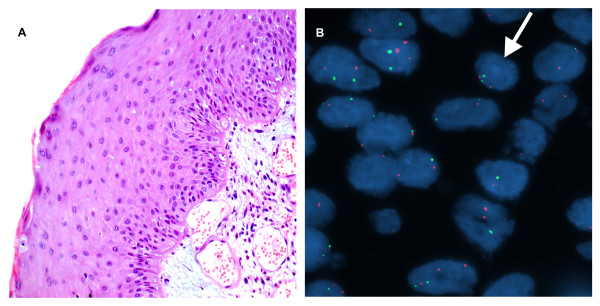
A case of mild dysplasia of the larynx. A. H&E stain. (×200). B. Interphase FISH displaying a CSP3: hTERC signal pattern of 2:2 (green:red). (×1000).